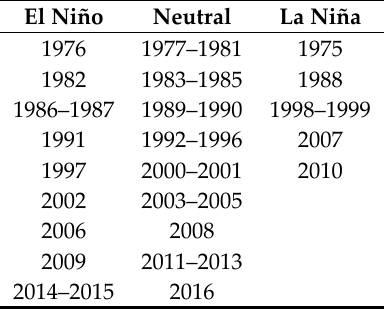
Table 1. List of ENSO years used here. The years are taken from [24].